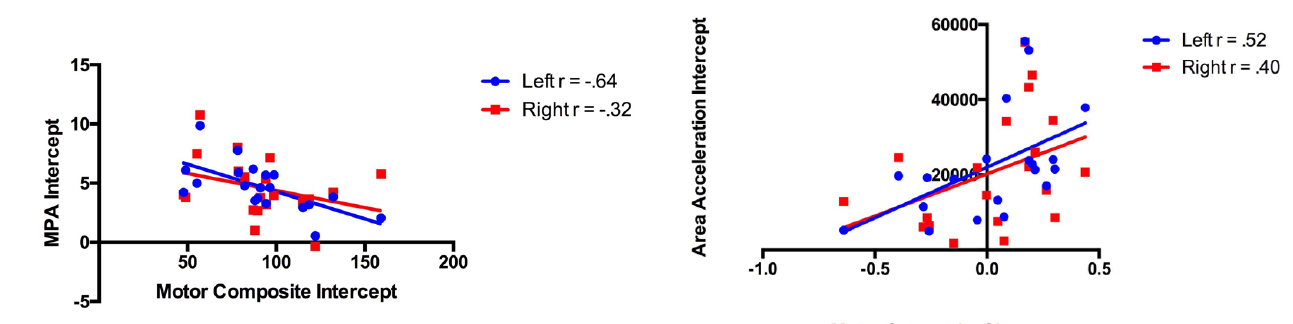
infant.Figure 11. Scatter plot of mean peak acceleration (MPA) intercepts (for right and left arms) and Bayley composite motor intercepts of each